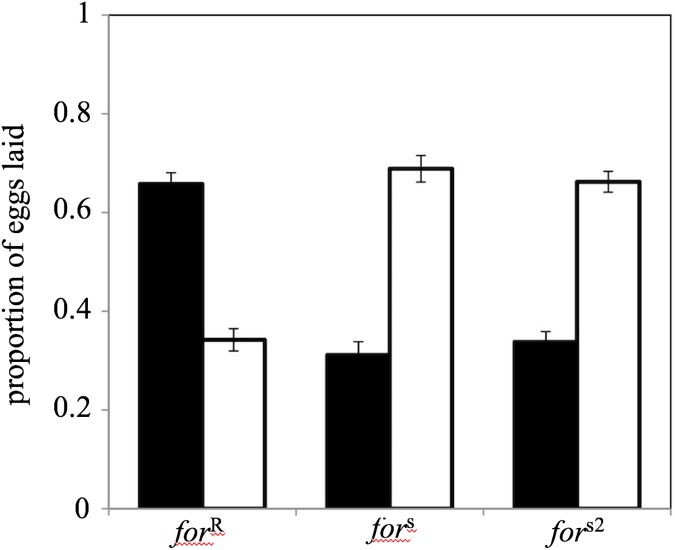
Oviposition preferences are mediated by for.forR flies preferentially lay on low-nutrient substrates whereas both fors and fors2 flies preferentially lay on high-nutrient substrates. Dark bars represent low-nutrient patches and open bars represent high-nutrient patches. Values represent the mean ± s.e.m. n = 20 replicate trials per genotype.